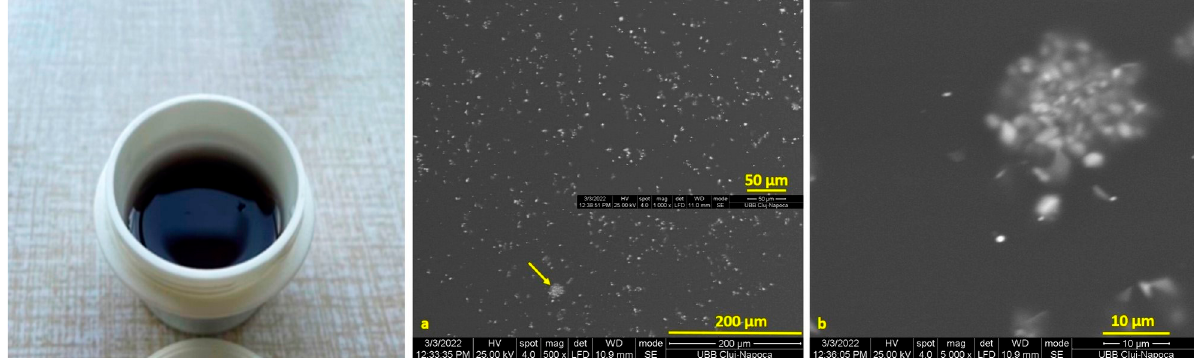
Figure 1. Images of the Cu-PEG 400 mixture (in plastic minicontainer) and ( a , b ) SEM images of Cu SO 4 -PEG 400.